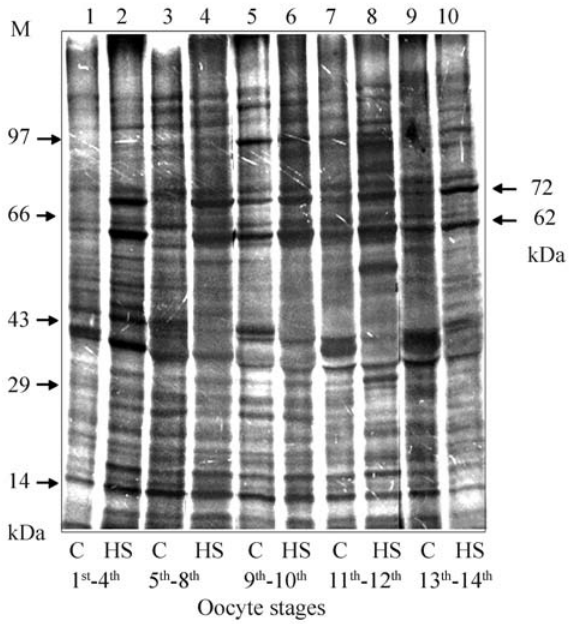
Figure 3A - Autoradiograph showing the expression patterns of the 62 kDa (HSP60) and 72 kDa (HSP70) proteins during the 1 st -4 th , 5 th -8 th , 9 th -10 th , 11 th -12 th and 13 th -14 th stages of oocyte development in M. domestica at the control (C, 25 °C) and heat shocked (HS, 42 °C) tempera- tures